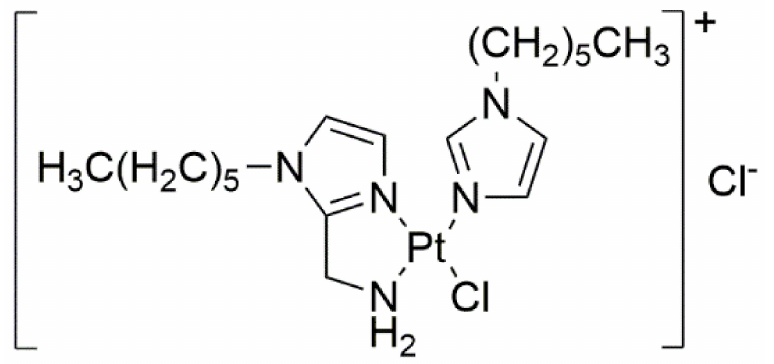
Figure 7. Novel cationic platinum(II)-complex